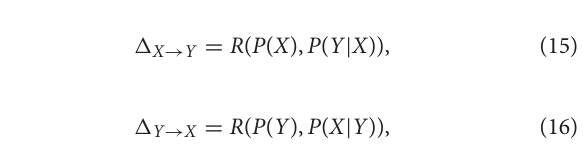
(18,18). Simulation scenario 4, (|X|,|Y|) =